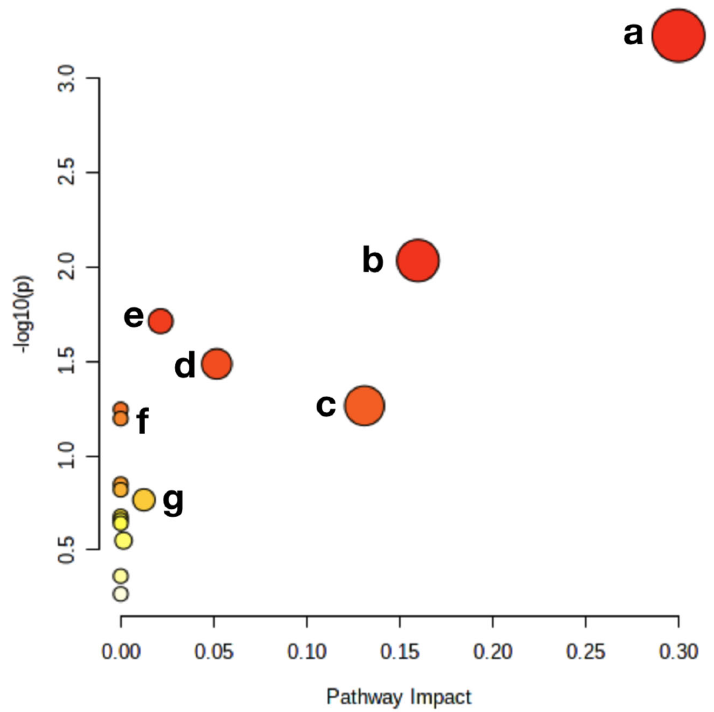
Figure 11. Metabolic pathway analysis. a: Glycerophospholipid metabolism; b: Pyrimidine metabo ‐ lism; c: Cysteine and methionine metabolism; d: Lysine degradation; e: Pantothenate and CoA bio ‐ synthesis; f: Pentose phosphate pathway; g: Arachidonic acid metabolism.